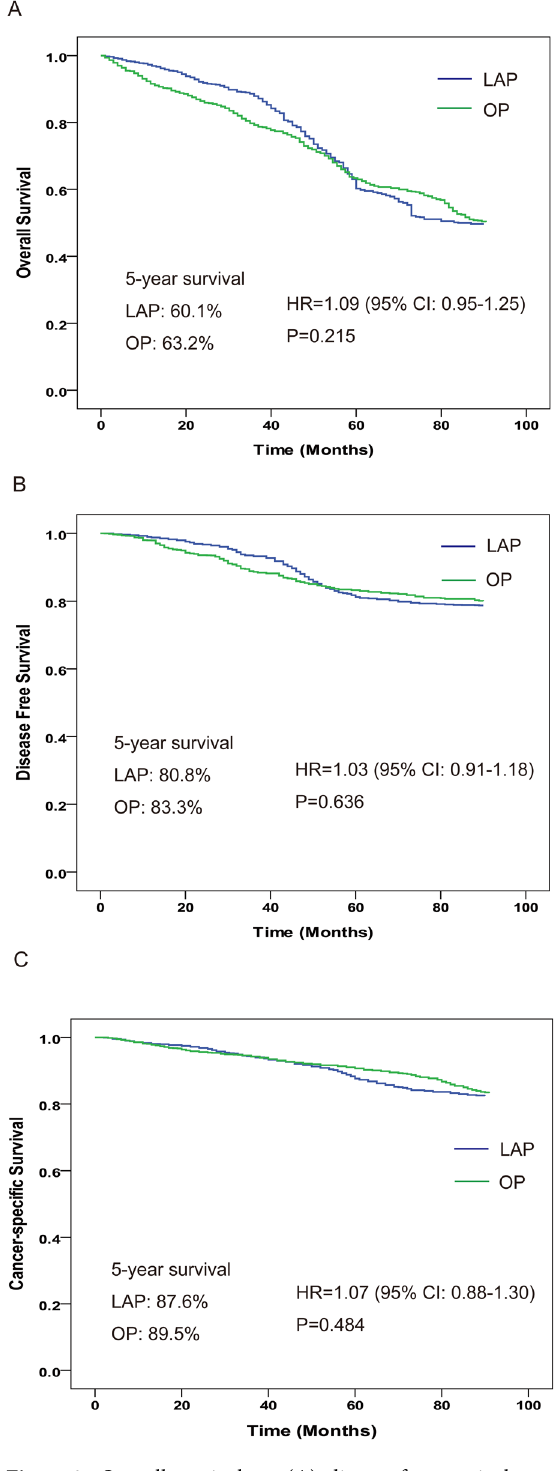
Figure 2. Overall survival rate ( A ), disease-free survival rate ( B ), and cancer-specific survival rate ( C ) in LAP and